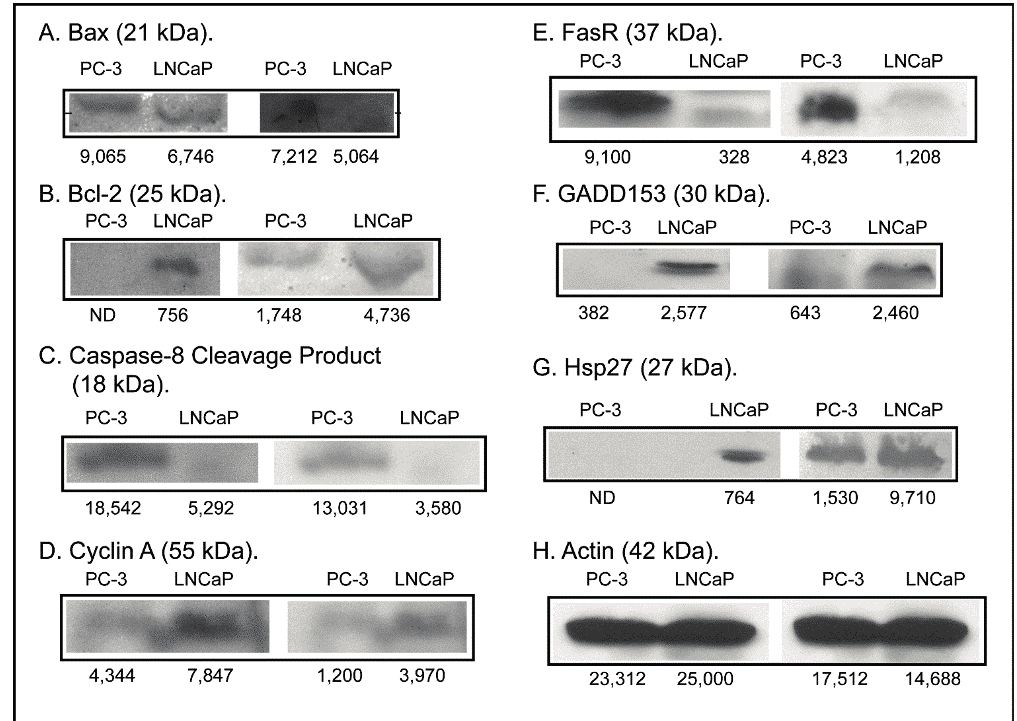
Figure 5. Western blot analysis of selected proteins regulating apoptosis, cell growth, and stress response. Protein (100 µg) from total cell extracts of PC-3 and LNCaP cells were loaded onto 10%, 12%, or 15% SDS polyacrylamide gels. After electroblotting of protein onto nitrocellulose paper, blots were blocked for 1 h in 5% milk powder solution and incubated overnight with primary antibody. Blots were washed 3× with TTBS and incubated with appropriate secondary antibody conjugated to alkaline phosphatase (Jackson ImmunoResearch, West Grove, PA, USA) or horseradish peroxidase, for 1 h. Blots were washed 3–6× in TTBS and then assayed for color development using BCIP/NBT as substrates (Promega, Madison, WI, USA) or using the Pierce ECL Western Blotting Substrate Kit. β -Actin was used as a housekeeping protein. Band density for samples was determined with GelEval 1.3.7 for Mac OS X. Results are from two sets of cell cultures for each cell